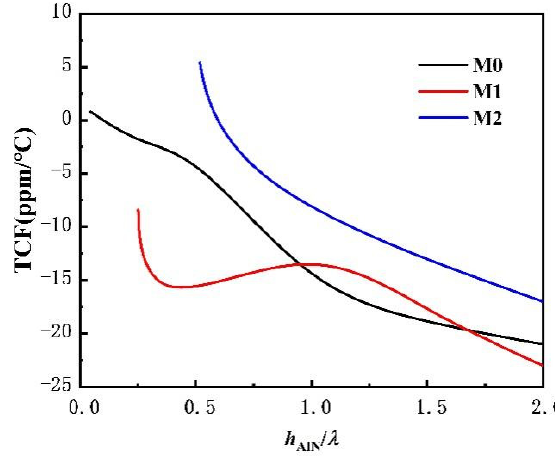
Figure 9. Curve characteristics of TCF against h AlN / λ .